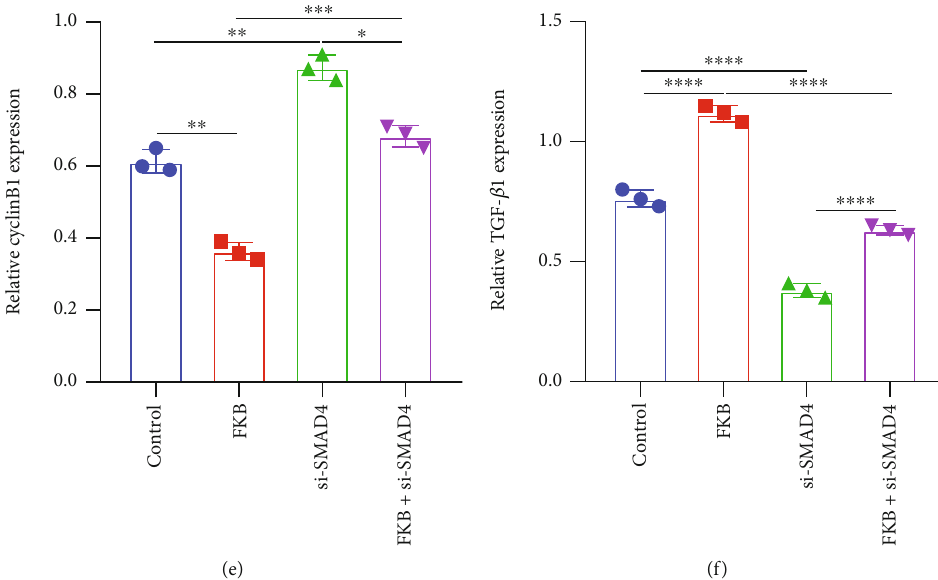
Figure 6: FKB weakens the expression of cell cycle-related proteins and TGF- β 1 in gastric cancer cells related to SMAD4. (a) Representative images of western blots. (b) Cdc2, (c) Cdc25C, (d) cyclin A, (e) cyclin B1, and (f) TGF- β 1 expression was quanti fi ed in SGC-7901 cells transfected with FKB and/or si-SMAD4. ∗ p < 0 : 05 ; ∗∗ p < 0 : 01 ; ∗∗∗ p < 0 : 001 ; ∗∗∗∗ p < 0 : 0001